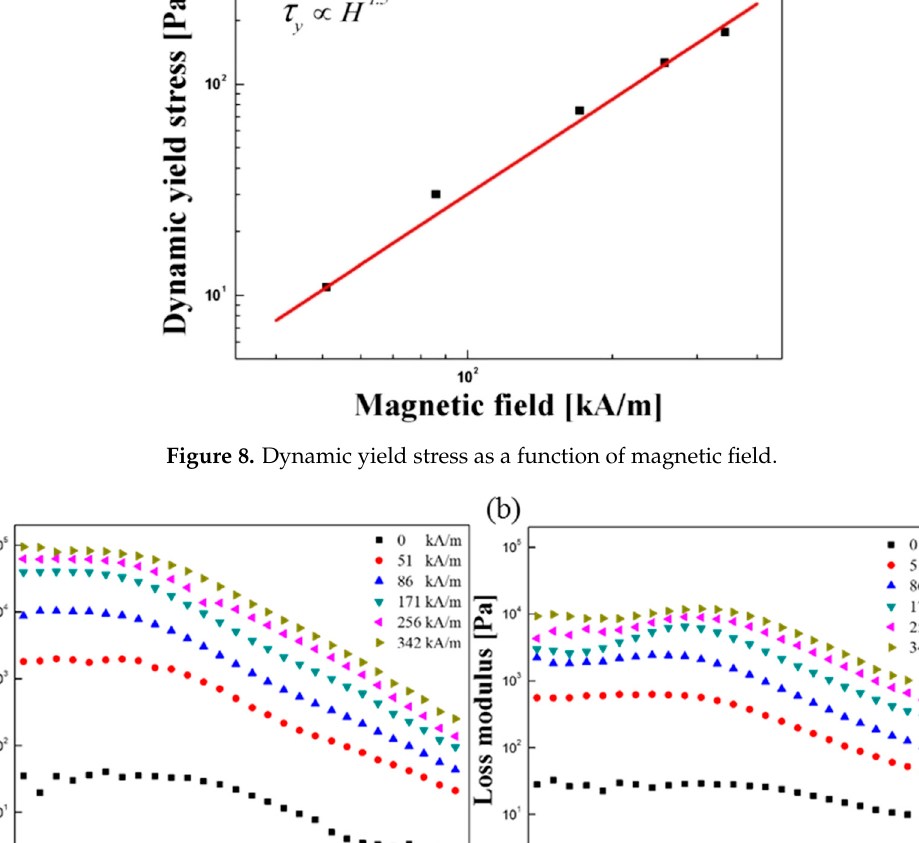
Figure 10. ( a ) Storage modulus; ( b ) loss modulus for core-shell microspheres Fe 3 O 4 / POA (10 vol %) MR suspension under various magnetic field strengths.